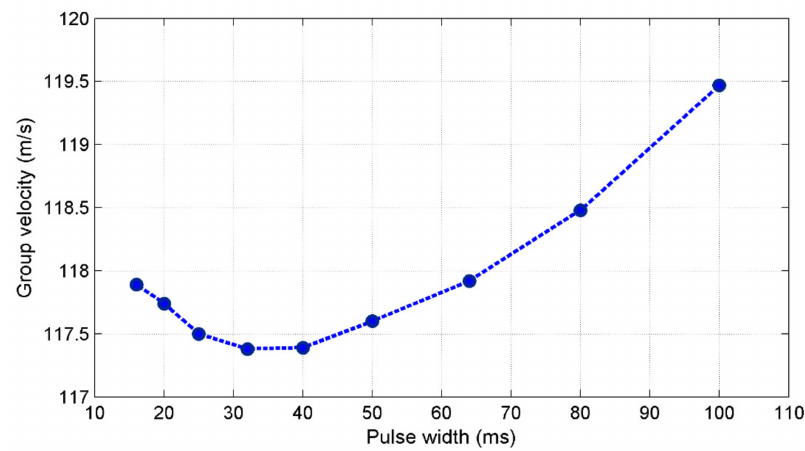
Figure 10. Variation in wavelet speed with drive pulse widths ( τ ).